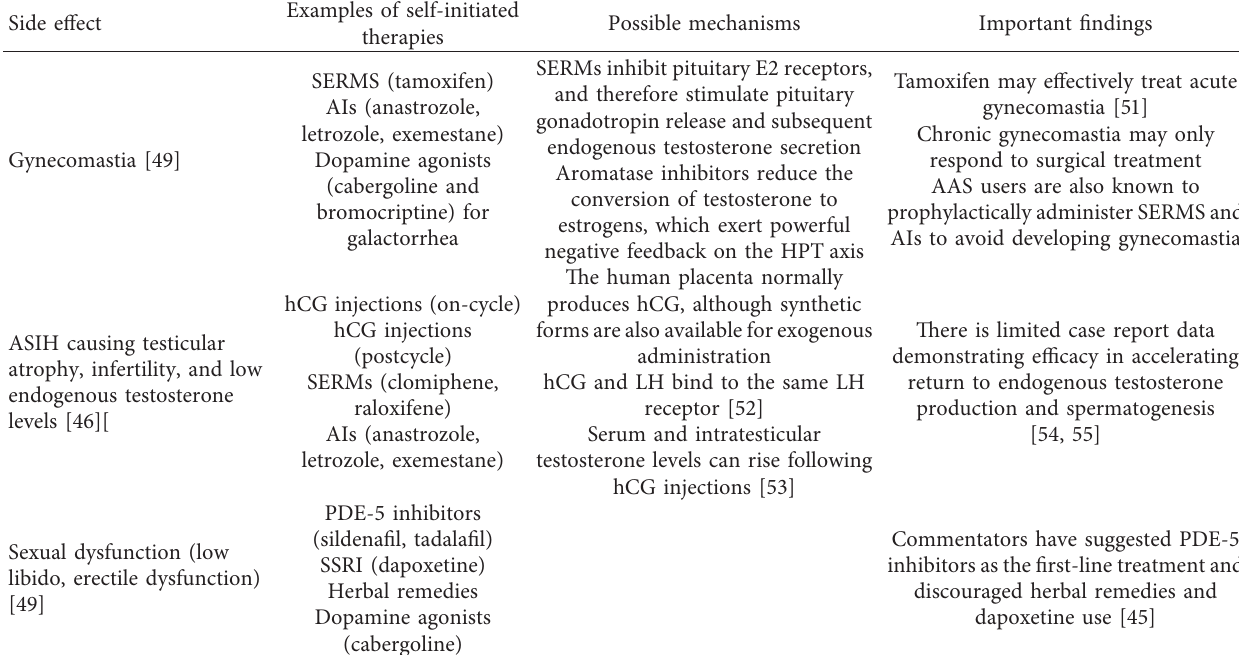
Table 4: Commonly encountered side effects in the “postcycle”